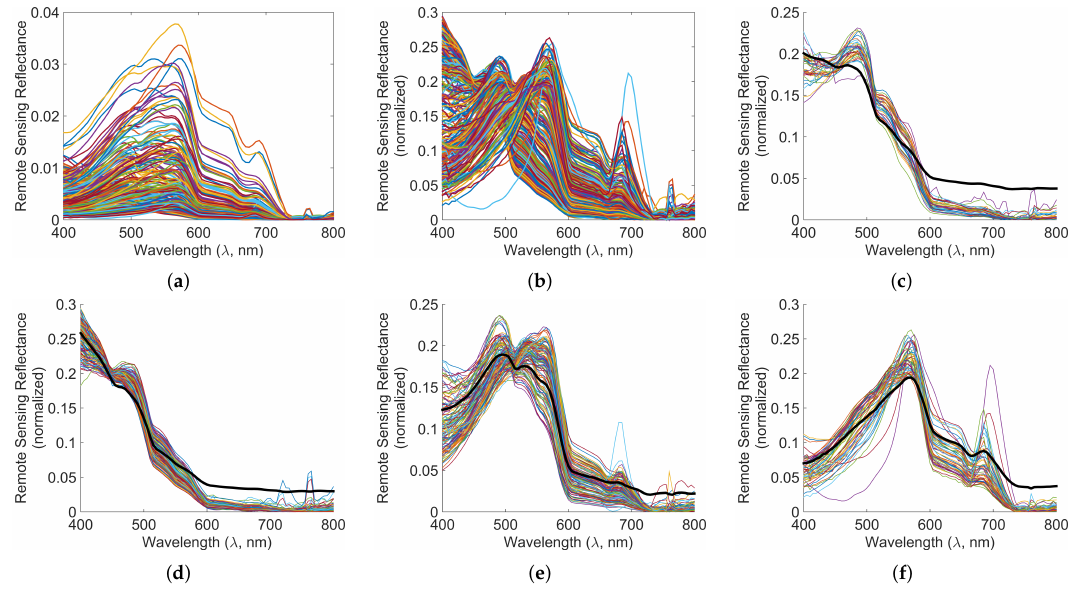
Figure 2. Normalized spectral data and spectral clusters of Dataset 2. The thick black lines in subfigures ( b – f ) show the centroids (cid:126) ρ ◦ of the clusters. ( a ) Reflectances (cid:126) R m ; ( b ) normalized reflectances (cid:126) ρ m ; ( c ) Class 1; ( d ) Class 4; ( e ) Class 6; ( f ) Class 8. Sensors: Six satellite remote sensors—MODIS (8 bands), MERIS (11 bands), SeaWiFS (7 bands), CZCS (4 bands), OLCI (15 bands), and VIIRS (7 bands)—are used in the synthetic experiments. A field measurement multiband photometer SeaPRISM from CIMEL Electronique has also been